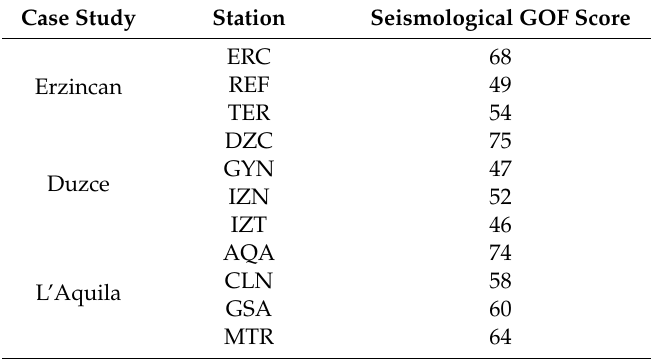
Table 5. Station-wise seismological GOF scores for all case